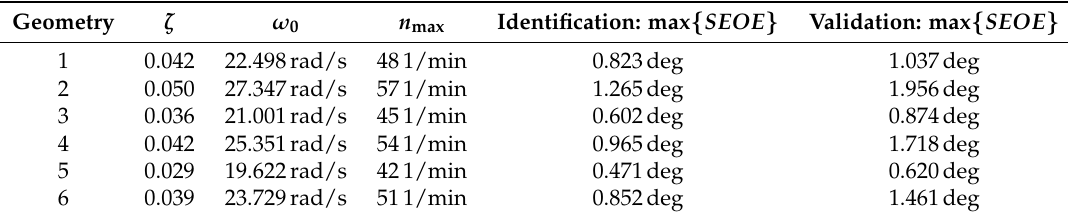
Table 4. Results of investigations: for each geometry, the derived model parameters as well as the maximum operating speed are stated. Furthermore, the maximum SEOE values are given for both the derived model applied to the identification motion profile and that applied to the validation motion profile.